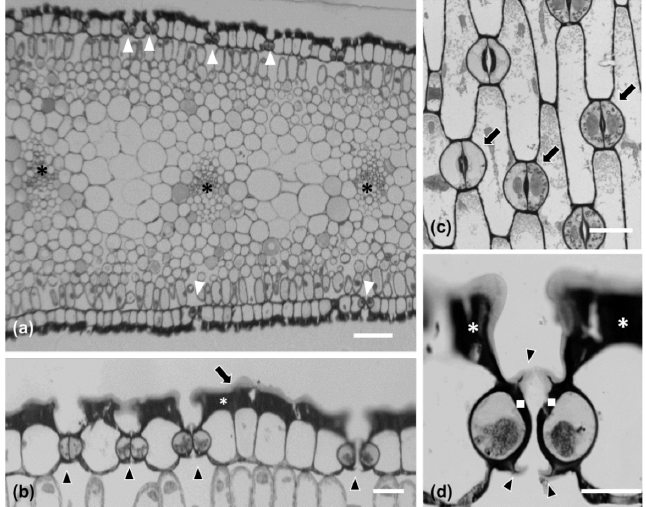
Figure 2. Leaf ( a,b ) and stomatal ( c,d ) morphological and anatomical characteristics in Pancratium maritimum . ( a,b,d ) Transverse sections after toluidine staining of resin-embedded material. ( a ) The leaf is amphistomatic [white arrows in ( a )], while vascular bundles are located in the middle of the mesophyll [asterisks in ( a )]. ( b ) Higher magnification of leaf epidermis. Leaf epidermis is covered by a thick cuticle [long arrow in ( b )]. Arrowheads point to stomata, while white asterisk shows the thick periclinal external cell wall of the epidermal cells. ( c ) Paradermal section of the leaf where anomocytic stomata (arrows) and pavement cells are shown. ( d ) Transverse section of a closed stoma where the cell wall thickenings of the ventral cell wall (white squares), as well as the ledges (arrowheads) are shown; the white asterisks depict epidermal periclinal cell wall thickenings. Scale bars: 20 μm.